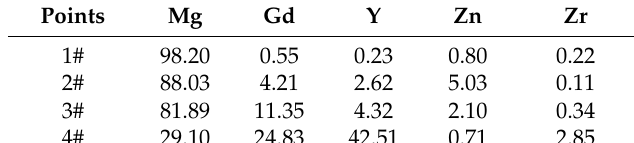
Table 1. The element atomic percentage of marked points in Figure 3c.